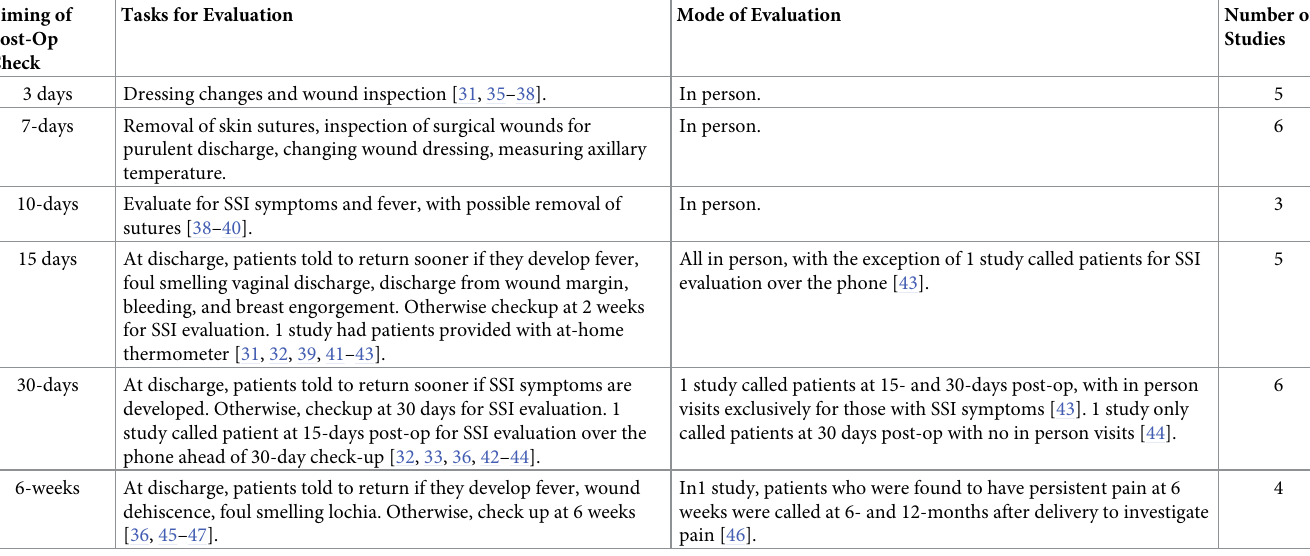
Table 1. Modalities of postoperative wound